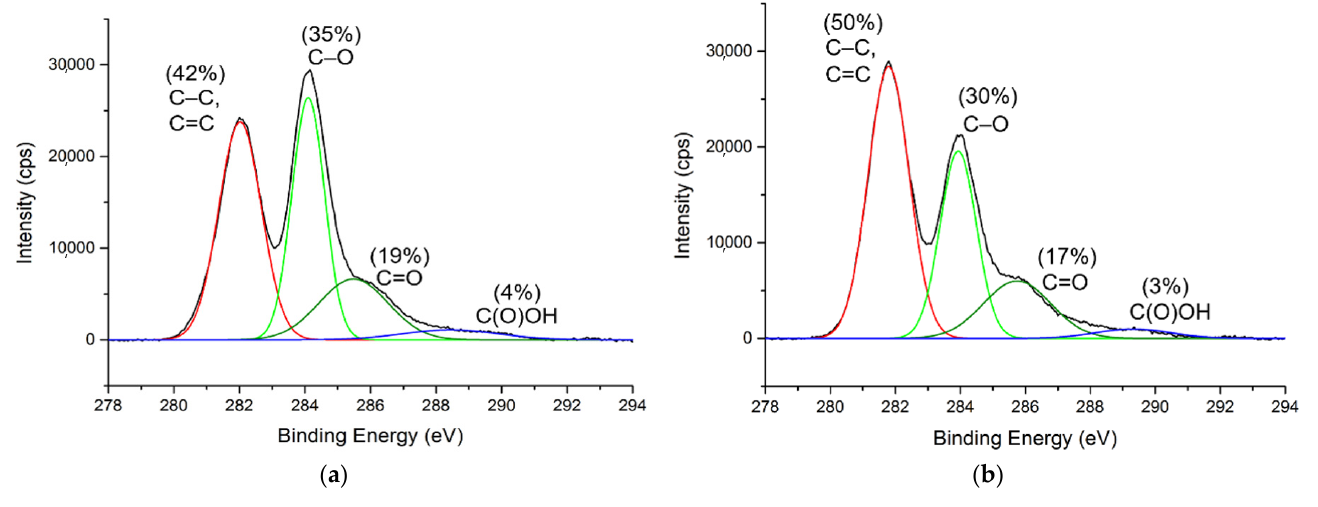
Figure 1. C1s XPS spectra of ( a ) GONs and ( b ) o-SWNTs.